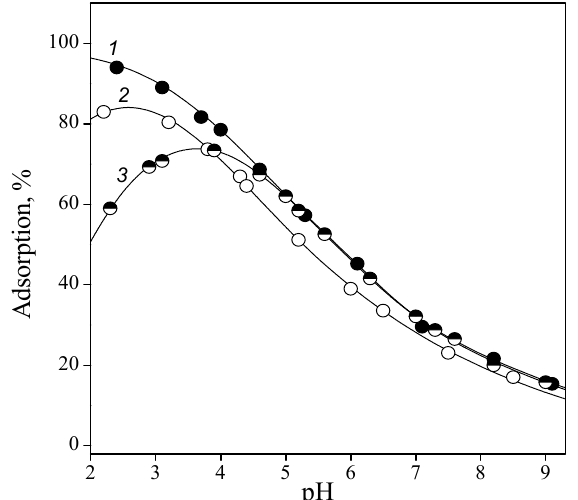
Figure 6. Adsorption of IMP ( 1 ), GMP ( 2 ), and AMP ( 3 ) from 0.01 M NaCl solution onto titanium oxide surface: C nucleotide = 0.1 nmmol/L, and C TiO2 = 1 g/L.